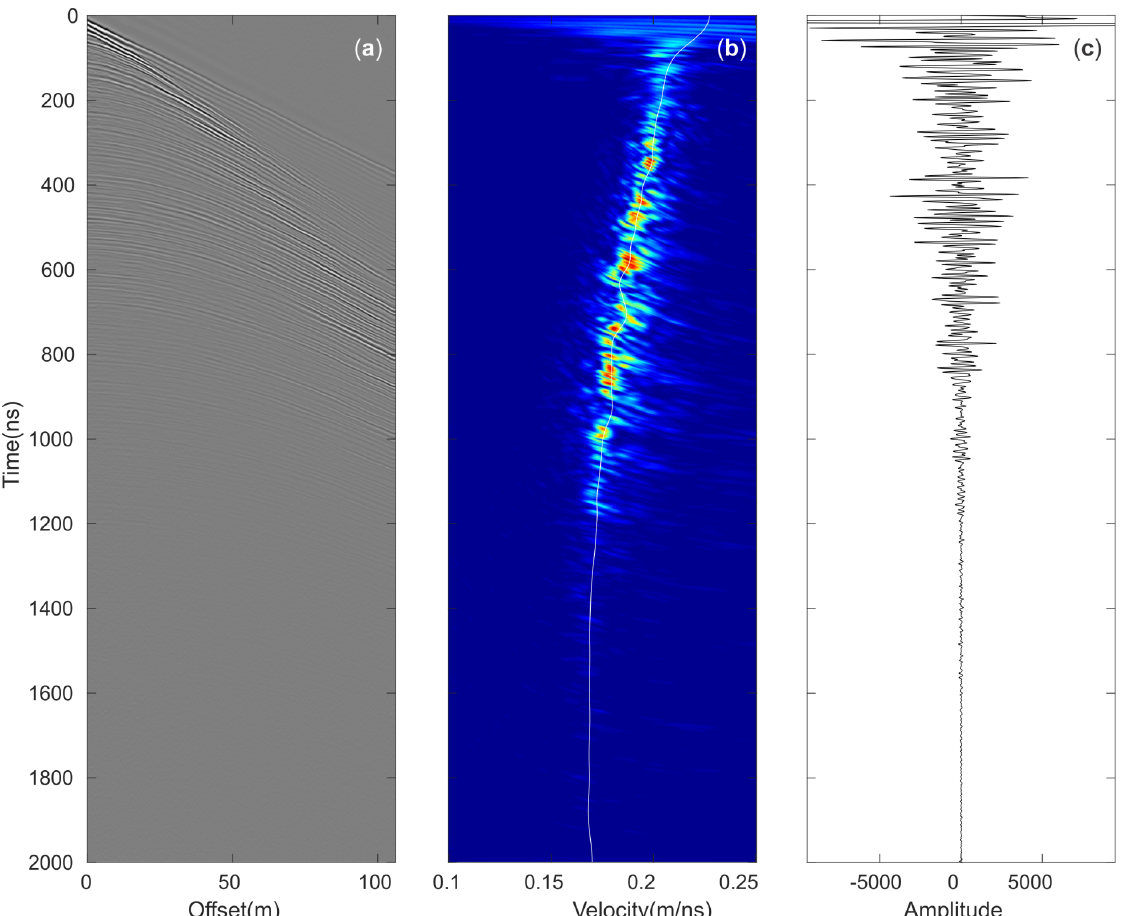
Figure 2. Panel ( b ) shows an automatic velocity picking on the semblance spectrum from gather G shown in Panel ( a ). Panel ( c ) shows the stacked trace for gather G